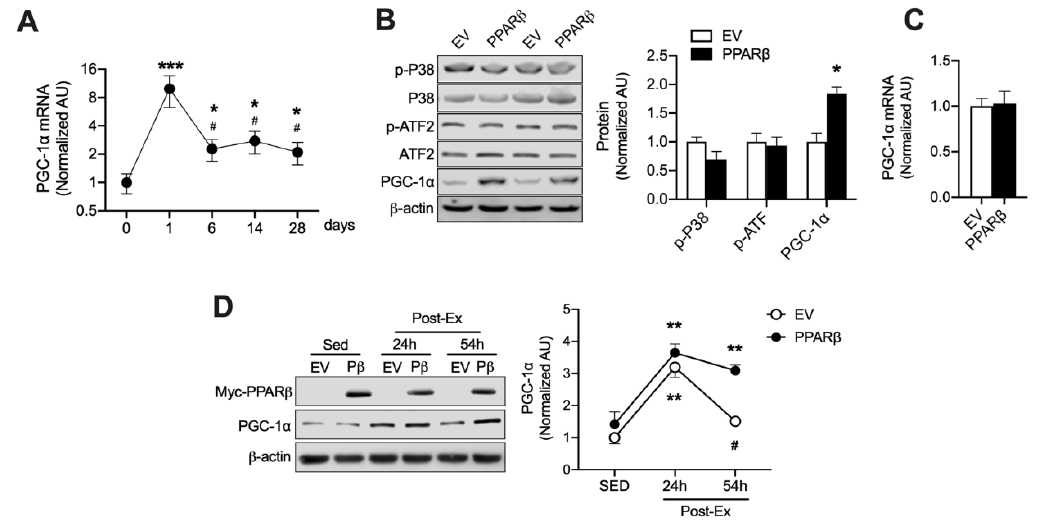
Figure 3. PPAR β regulates PGC-1 α protein levels in a post-transcriptional manner. ( A ) PGC-1 α mRNA is rapidly increased by a bout of exercise, and then downregulated at 6, 14, and 28 days of exercise training ( n = 6 muscles of mice per each day), Values are means ± SE. * p < 0.05, *** p < 0.01 versus day 0. # p < 0.05 versus 1 day of exercise training. Muscles were isolated immediately after Ext. ( B ) p38, ATF2 and PGC-1 α expression levels were determined in PPAR β -overexpressing skeletal muscles. Muscles were isolated 21 days after PPAR β overexpression through electroporation ( n = 4 muscle of mice per group). Values are means ± SE. * p < 0.05 versus EV. ( C ) PPAR β overexpression does not increase PGC-1 α mRNA ( n = 4 muscle of mice per group). Values are means ± SE. ( D ) PPAR β overexpression increases PGC-1 α protein stability in a post-transcriptional manner, empty vector (EV) or myc-PPAR β (P β ) was overexpressed in the tibialis anterior, and muscles were isolated at 24 and 54 h after acute exercise ( n = 6 muscles of mice per group). Values are means ± SE. ** p < 0.01 versus sedentary (Sed). # p < 0.01 verses PPAR β 54 h after acute exercise. Significance was determined using one-way ANOVA or Student’s t -test.